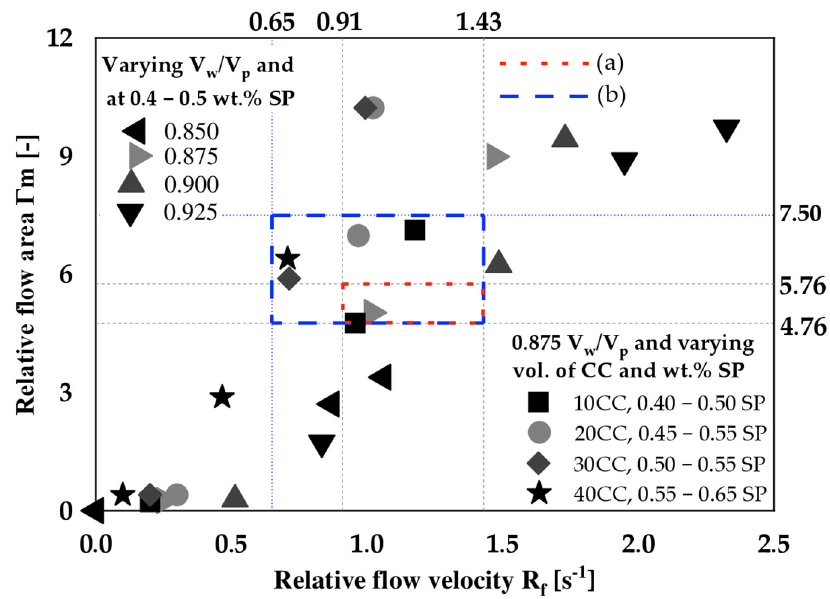
Figure 5. Г m and R f of SC-M, (a) = Г m and R f thresholds recommended by Okamura and (b) = proposed Г m and R f